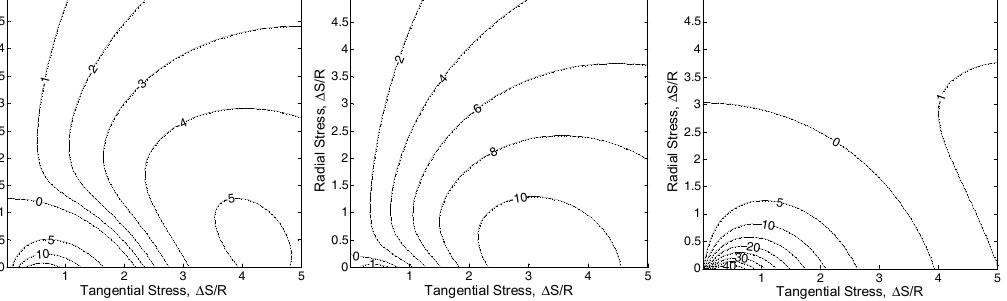
Figure 9. Error leakage in the vicinity of small increment less than ∆ s 1